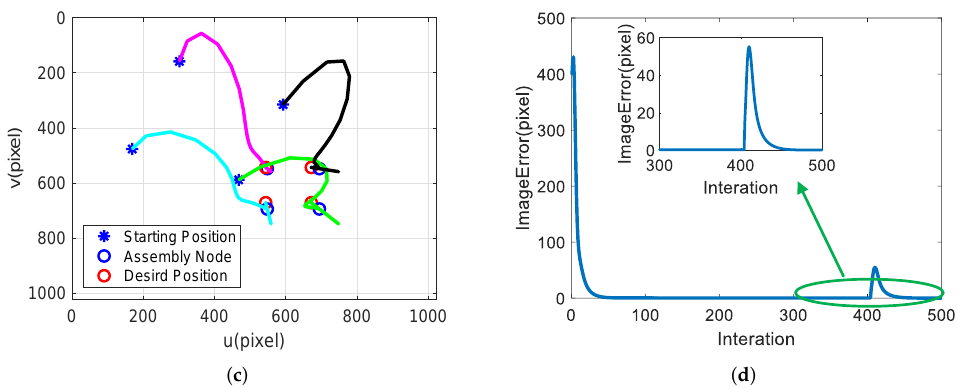
Figure 9. Results of the fourth simulation: ( a ) Complete Spatial trajectory of the robotic arm. ( b ) Dock- ing trajectory. ( c ) Image trajectory. ( d ) Position error in the image.